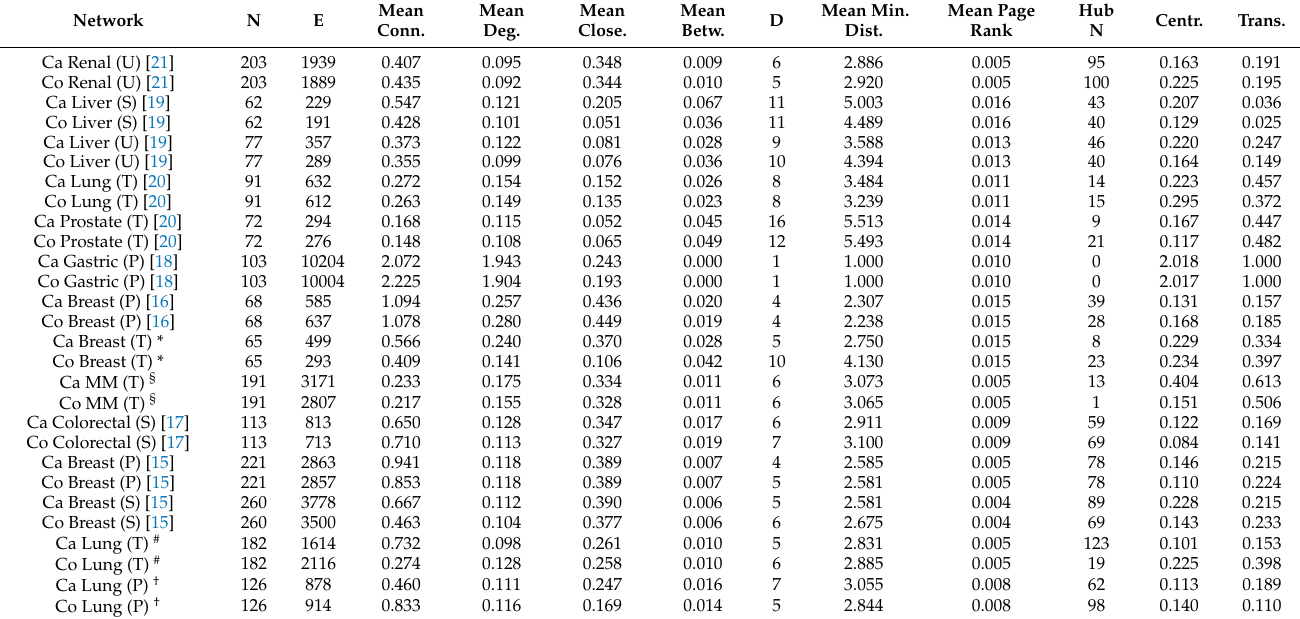
Table 3. Topological network characteristics of cancer (Ca) and control (Co) metabolite association networks across cancer types. Sample origin is labeled as T, U, S, P for tissue, urine, serum, and plasma, respectively. MM is multiple myeloma and data set identifiers are noted as: * ST000054, § ST000221, # ST000390 and † ST000396. Topological measures in the